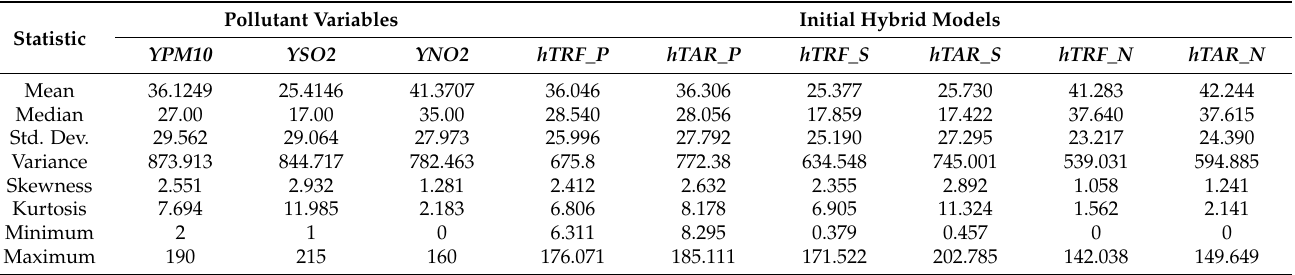
Table 4. Descriptive statistics of the initial hybrid models for the test sample vs. measured values a